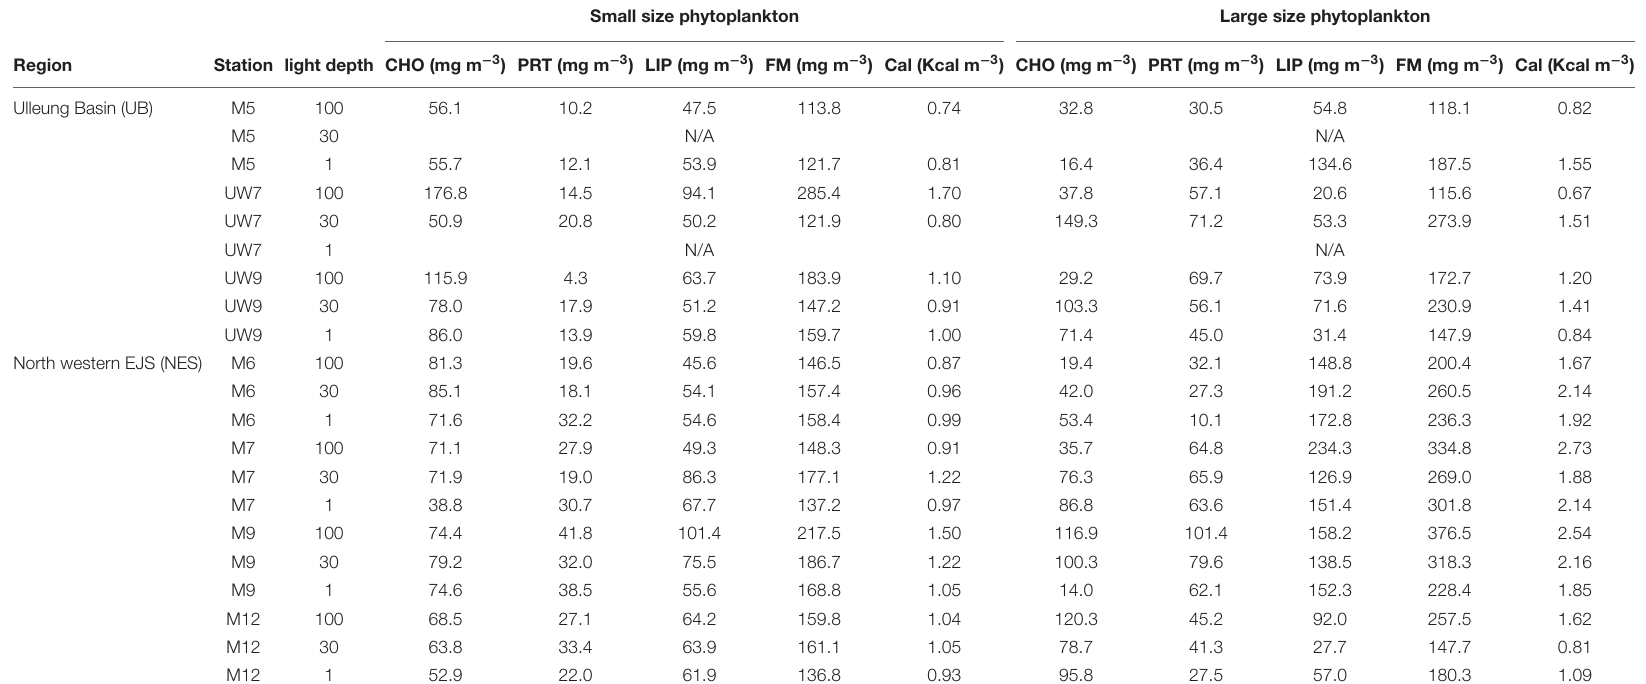
TABLE 2 | Concentrations of biochemical compositions, food materials, and calorific contents in the western EJS during the 2016 cruise. Small size phytoplankton Large size phytoplankton Region